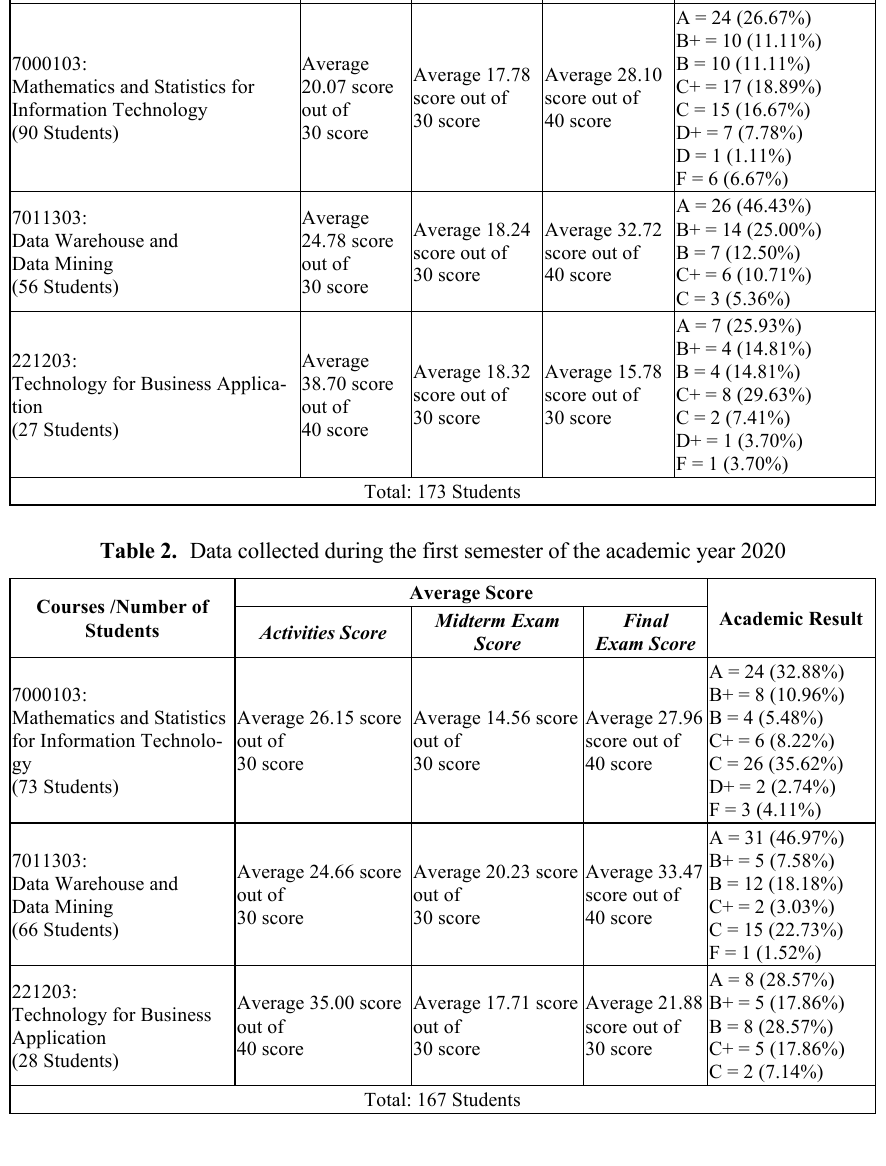
Table 1. Data collected during the second semester of the 2019 academic year Courses /Number of Students